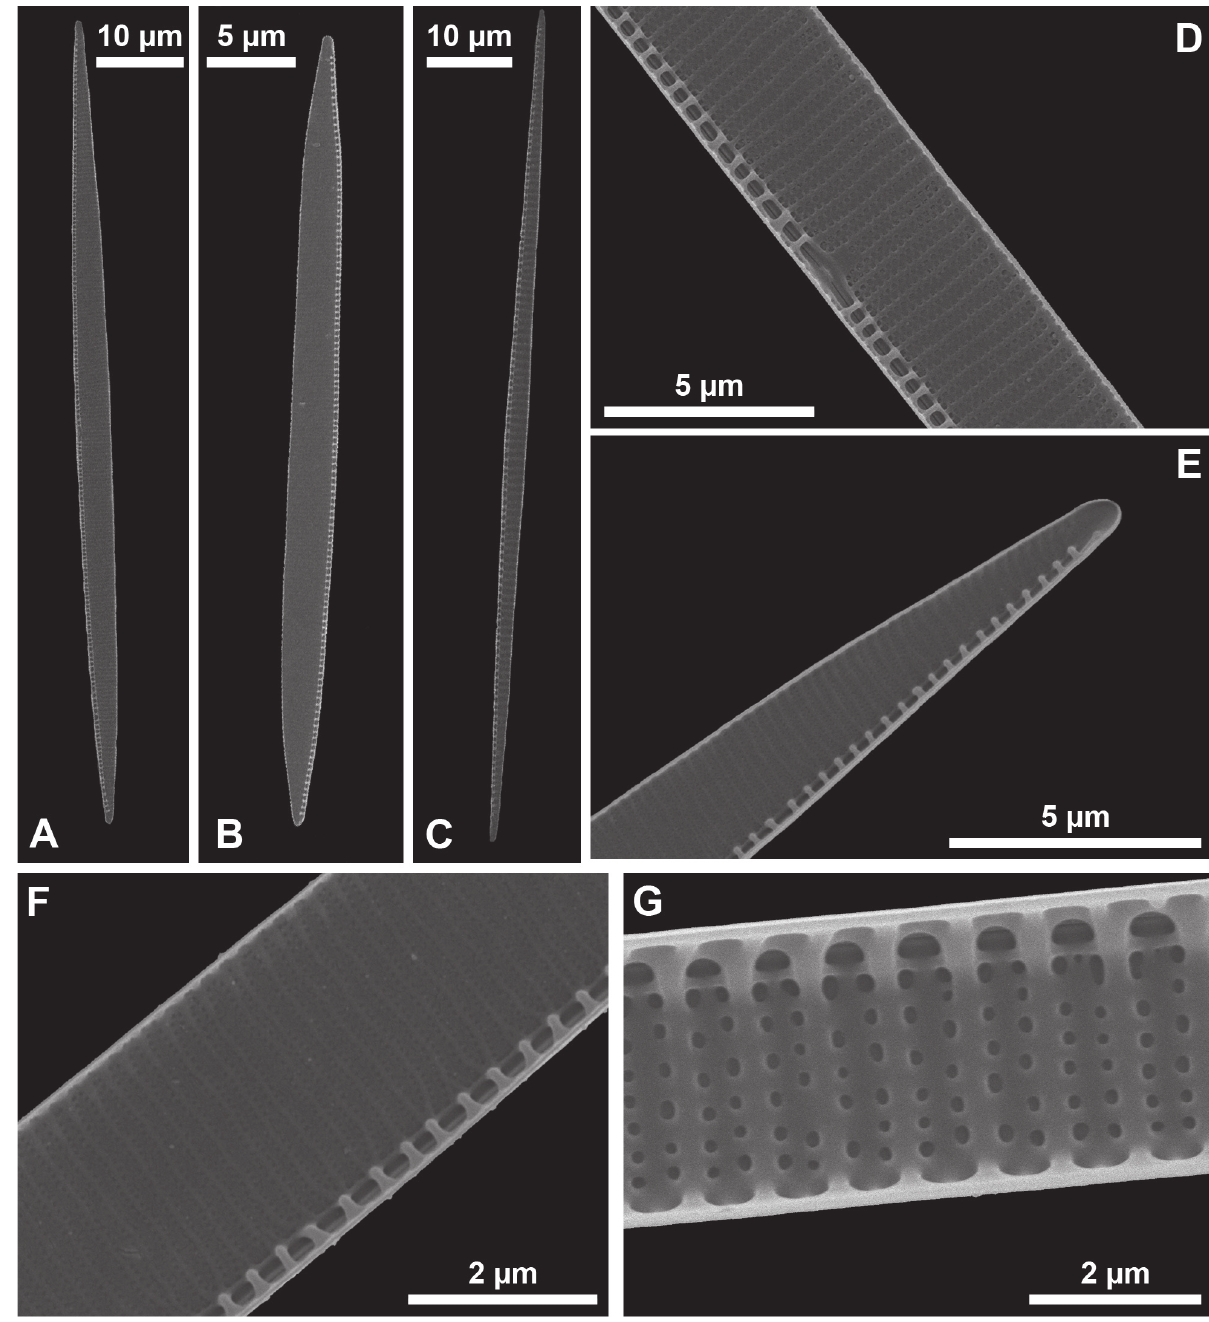
Fig . 3. – Sem (scanning electron microscopy) of Pseudo-nitzschia species in nW mediterranean Sea. a and d, P. fraudulenta (St. 22, 4/07/05); B, e and F, P. multistriata (St. 15, 28/08/05); c and g, P. pungens (St. 11,